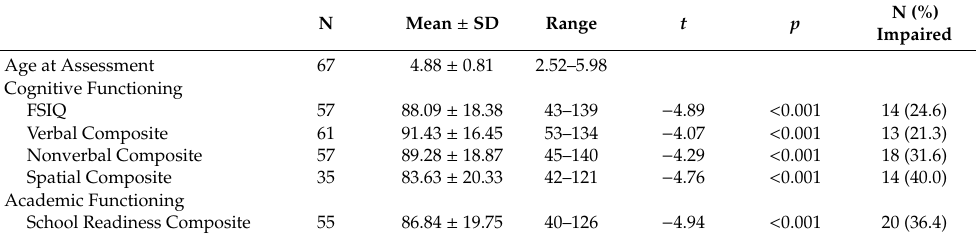
Table 3. Cognitive and academic